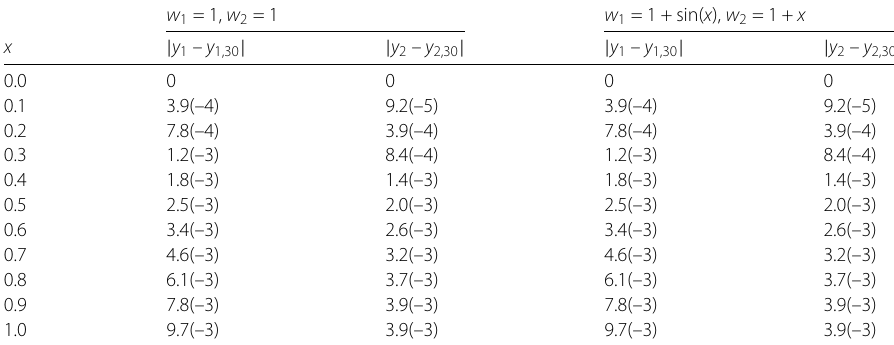
Table 7 Absolute errors of the presented method with n = 30 for Example 3 w 1 = 1, w 2 =